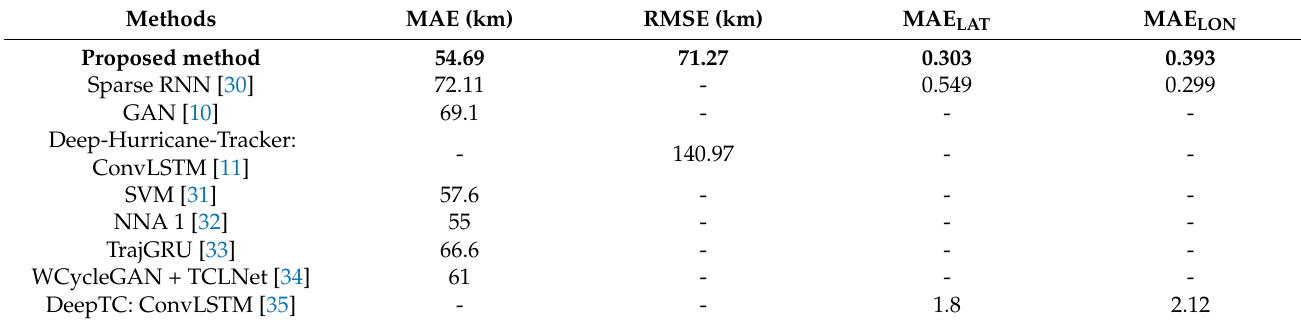
Table 4. Comparison of the results with other